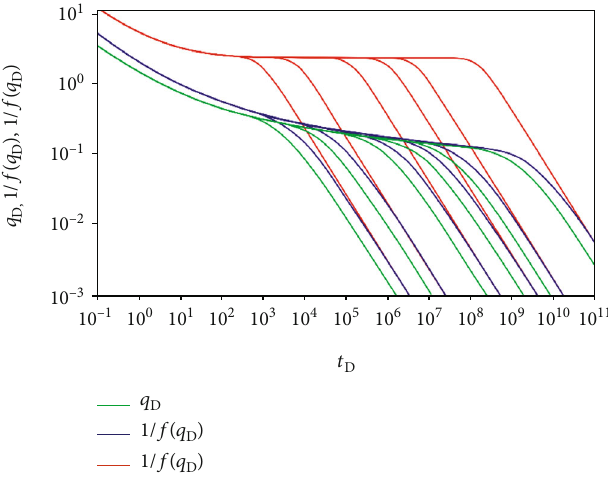
Figure 6: Type curves of rate decline for a homogenous reservoir.